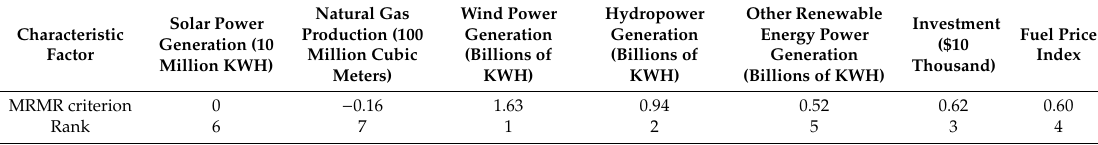
Table 4. mRMR calculation results of multi-energy